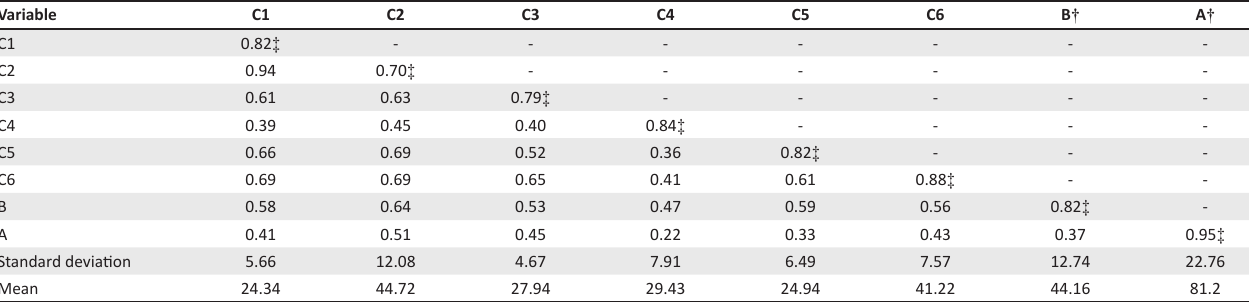
TABLE 1: Intra-scale correlation matrix, alpha coefficients and descriptive statistics.